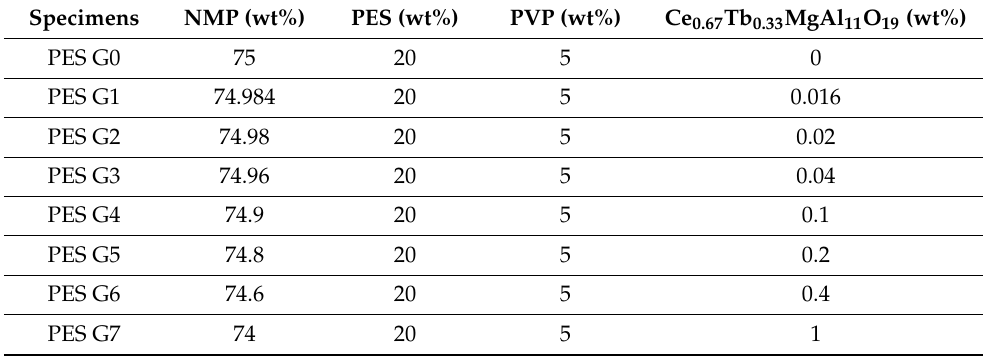
Table 2. The composition of PES membranes and concentrations of